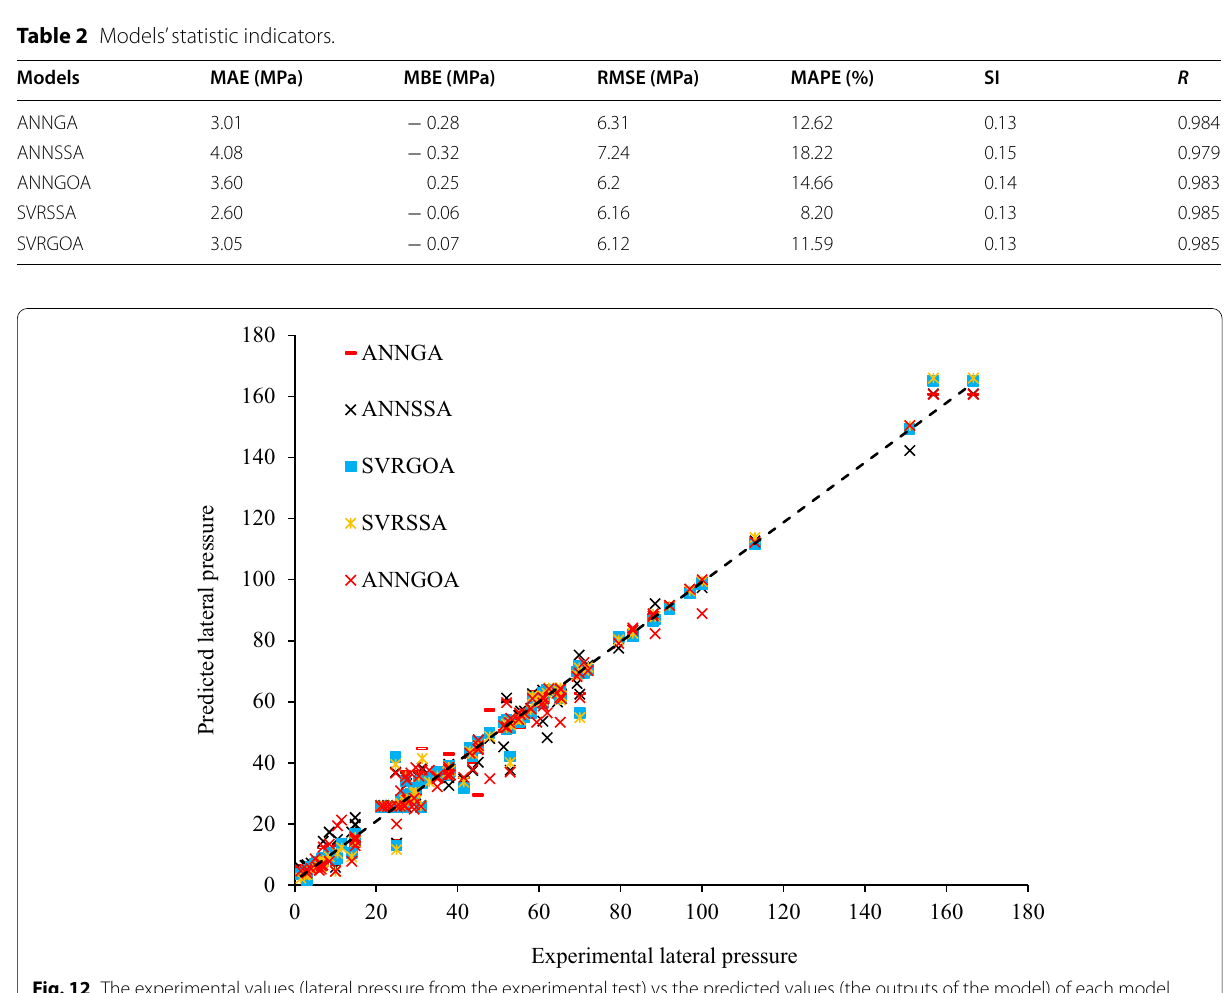
Fig. 12 The experimental values (lateral pressure from the experimental test) vs the predicted values (the outputs of the model) of each